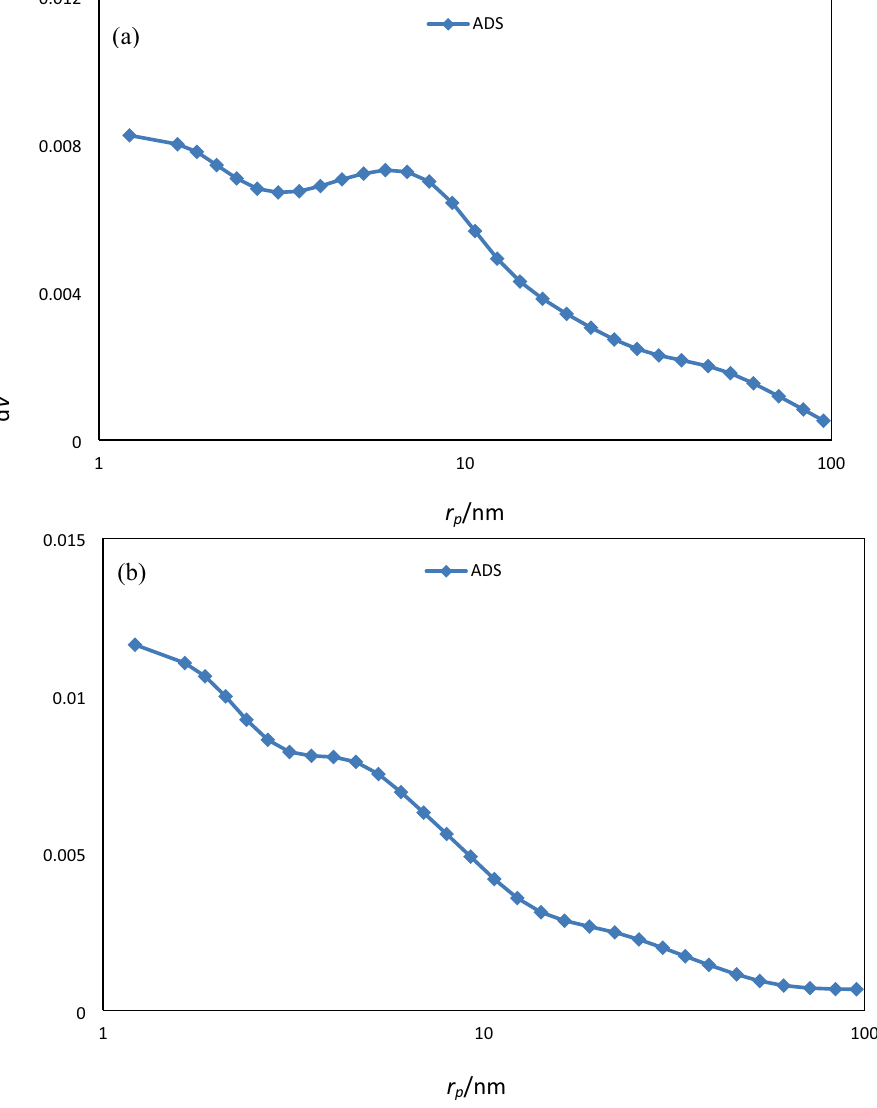
Figure 6. Pore size distribution for ( a ) T1–Z1/CS ( b ) T1–Z1/CS1–Gr2.